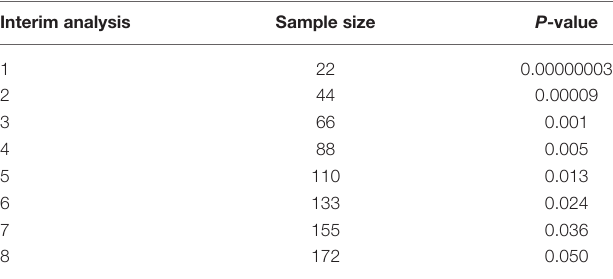
TABLE 3 | P -values (based on Lan-DeMets alpha spending function) indicating a necessary stop of the trial and needed sample size at each interim analysis. Interim